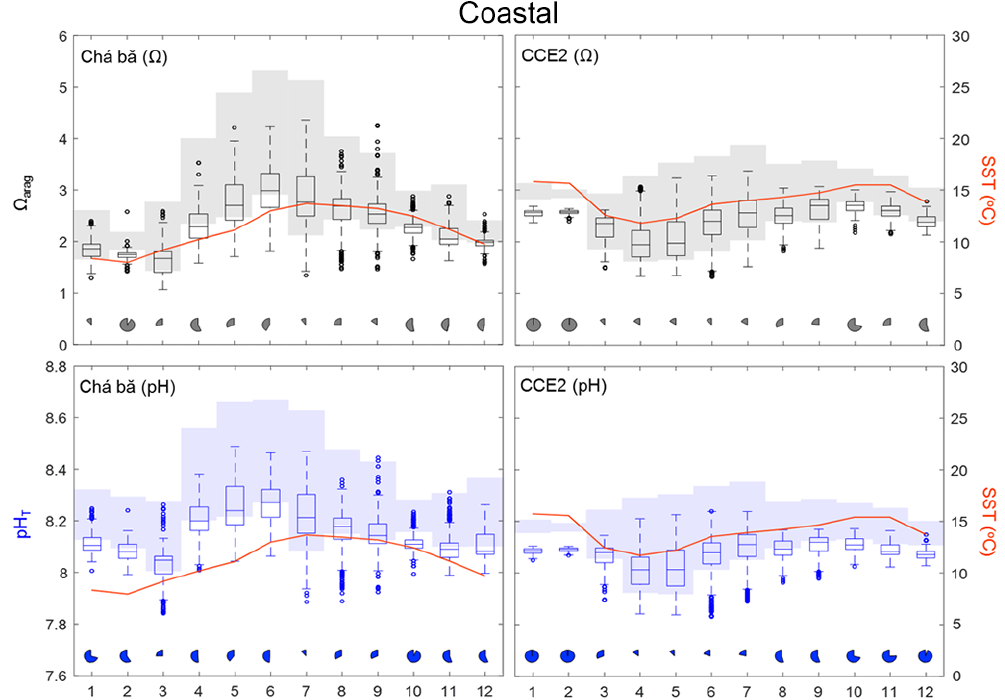
Figure 5. Box and whisker plots of present-day monthly surface seawater (cid:127) arag (top) and pH (bottom) and monthly mean SST at the coastal mooring locations on the continental shelves of the US west coast (CCE2, Chá b˘a). See detailed description of figure components in Fig. 2